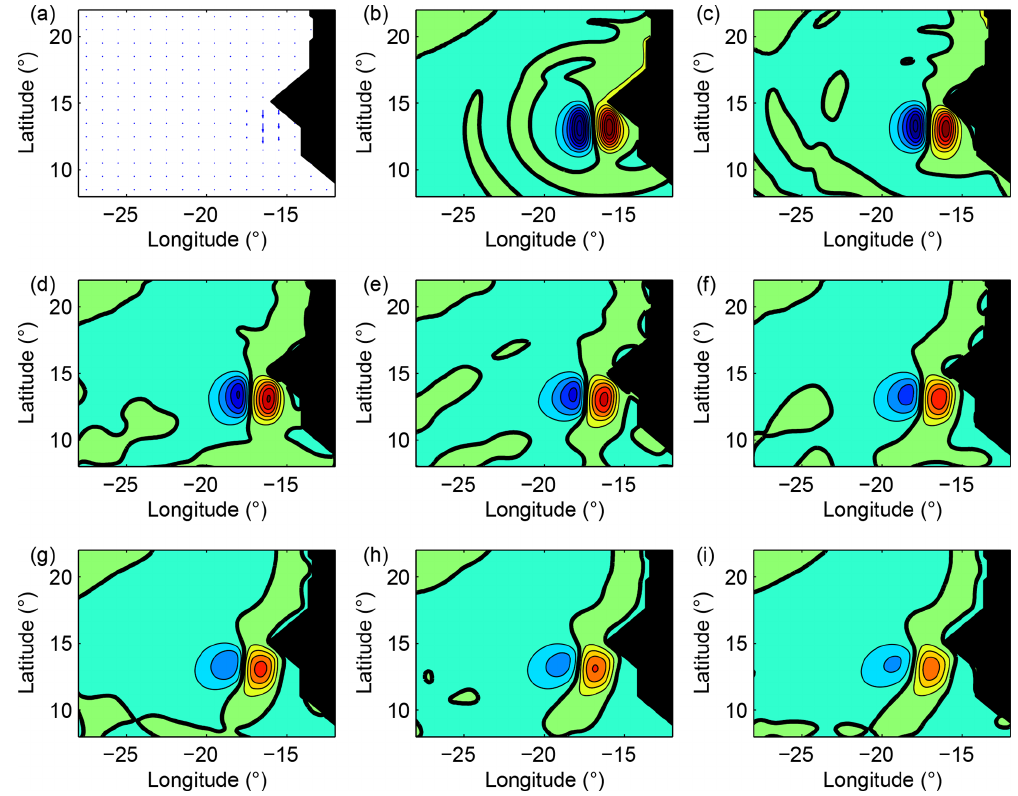
Figure 6. The wind anomaly extent is 4 times smaller than the one used in Fig. 4 and the position of the centre is kept unchanged (a) . It still acts for 5d, and as previously the active layer thickness is shown for every 5d from the close of the wind stress anomaly up to 35d after. A Rossby wave is generated and its extent is approximately 4 times smaller than previously. No Kelvin waves are created. The 0m isoline is indicated in bold; the isoline interval is 0.5m (blue: